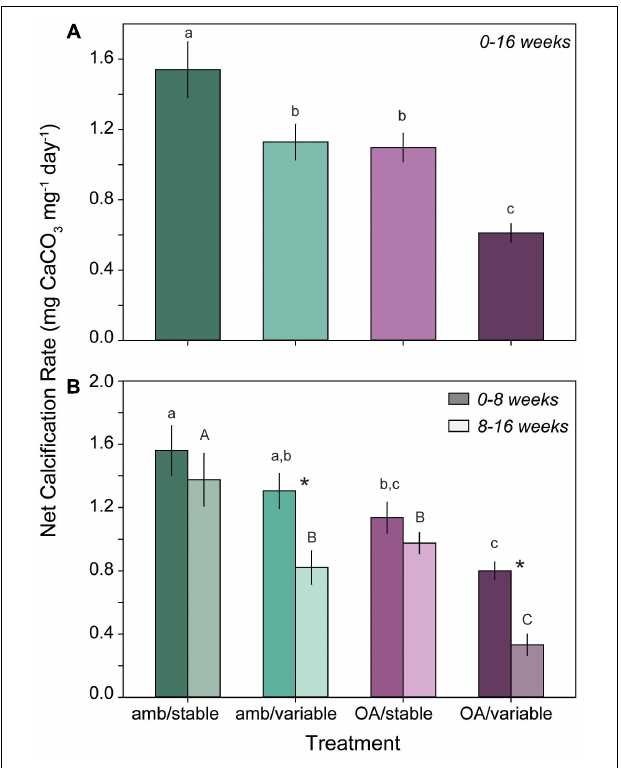
FIGURE 3 | (A) Mean ( ± SE) total calcification rate of L. congestum over the full duration of the experiment (0–16 weeks) ( n = 6) and (B) during the first (0–8 weeks, dark shade) and second (8–16 weeks, light shade) halves of the experiment ( n = 6). Treatments with different letters are significantly different at α = 0.05, case denotes statistical differences within a time point. Asterisk indicates a significant difference within a treatment between time